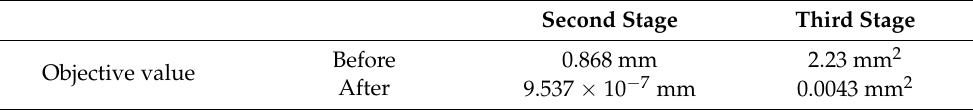
Table 3. The comparison of objective value before and after computing in